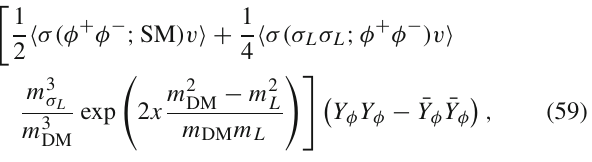
Fig. 2 Left: Y i as a function of x . Right: The total relic abun- dance (cid:4) h 2 against the decay width (cid:2) γ(σ L ) (cid:3) in the range ( 0 . 1 − − 2 . 0 ) × 10 12 GeV. We have used: m GeV, (cid:2) σ(σ L σ L ; φ + φ − )v (cid:3) = 5 . 2 × 10 − 6 GeV − 2 , (cid:2) σ(σ L σ L ; SM )v (cid:3) =